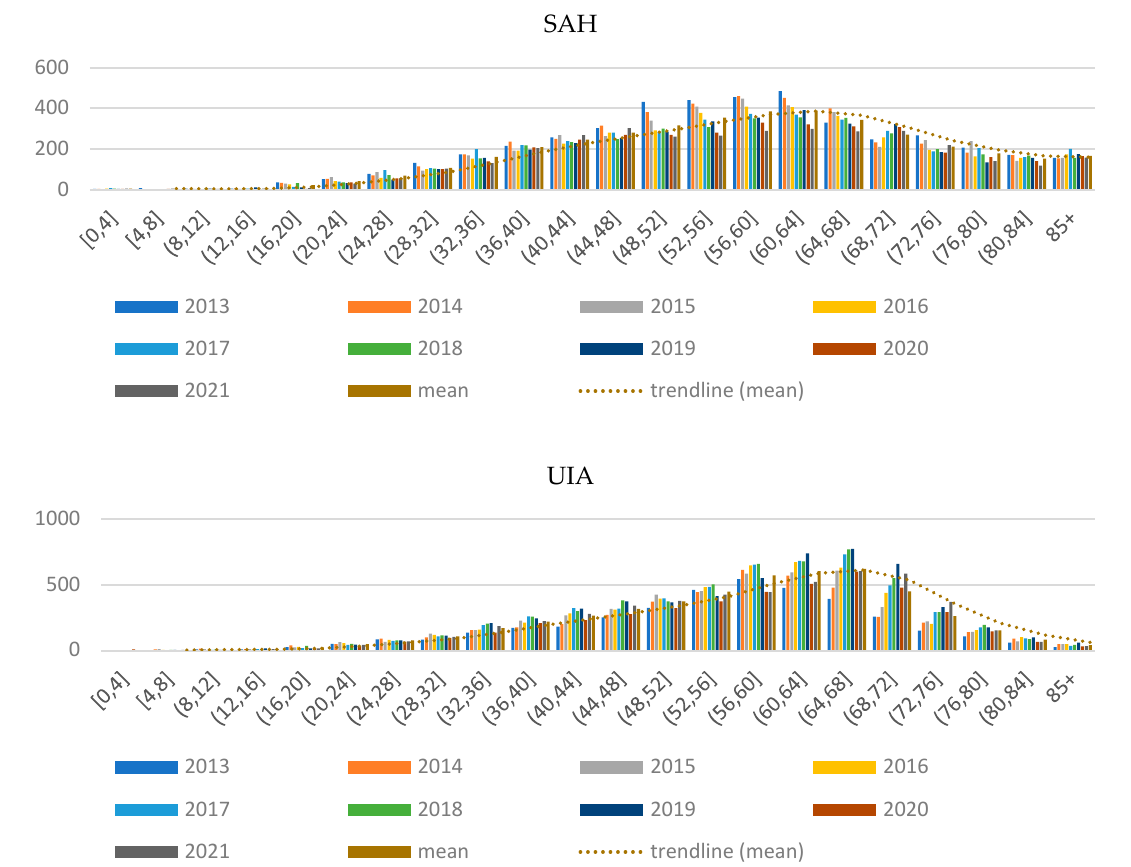
Figure 1. The distribution of the number of patients according to age.